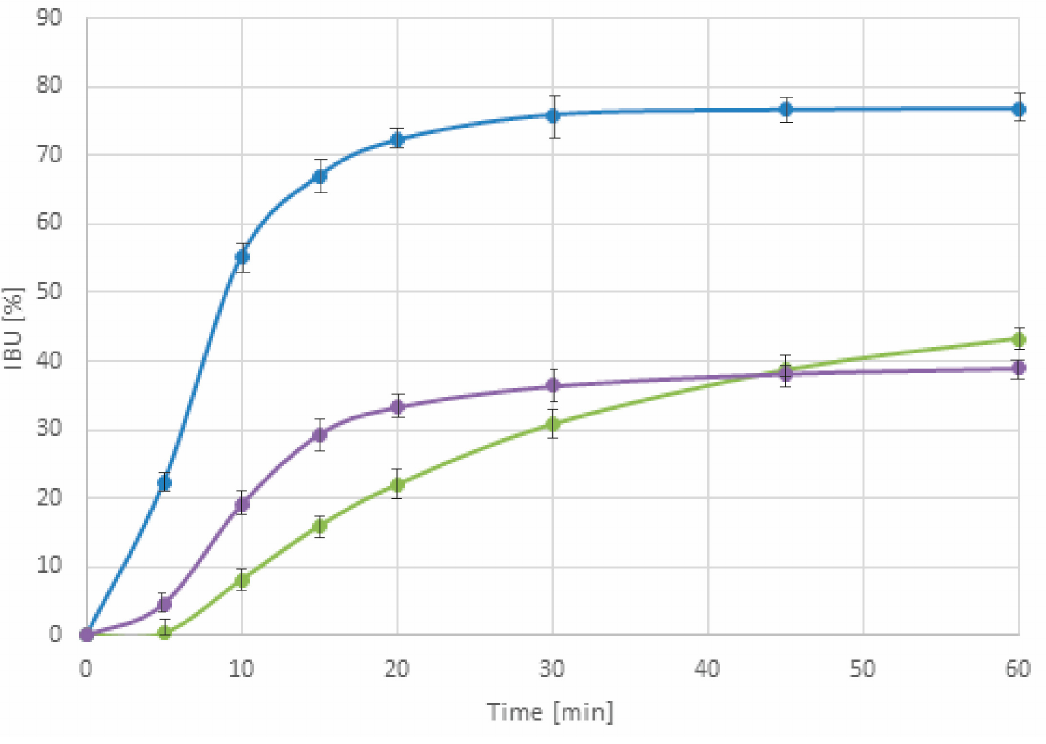
Figure 8. Dissolution profiles for tablets containing IBU–Neusilin extrudates (blue line) and commercially available product containing ibuprofen tablets (green line) and soft gelatin capsules in 0.1 M hydrochloric acid, 900 mL, 50 RPM, paddle apparatus.